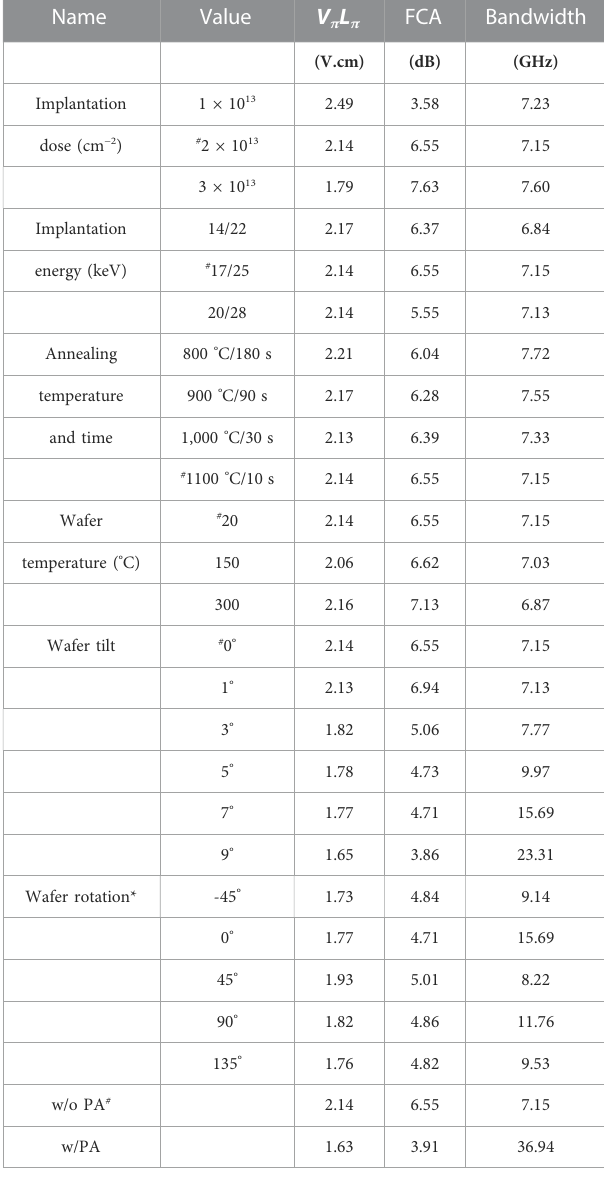
TABLE 1 Performance comparison of different process parameters at -5